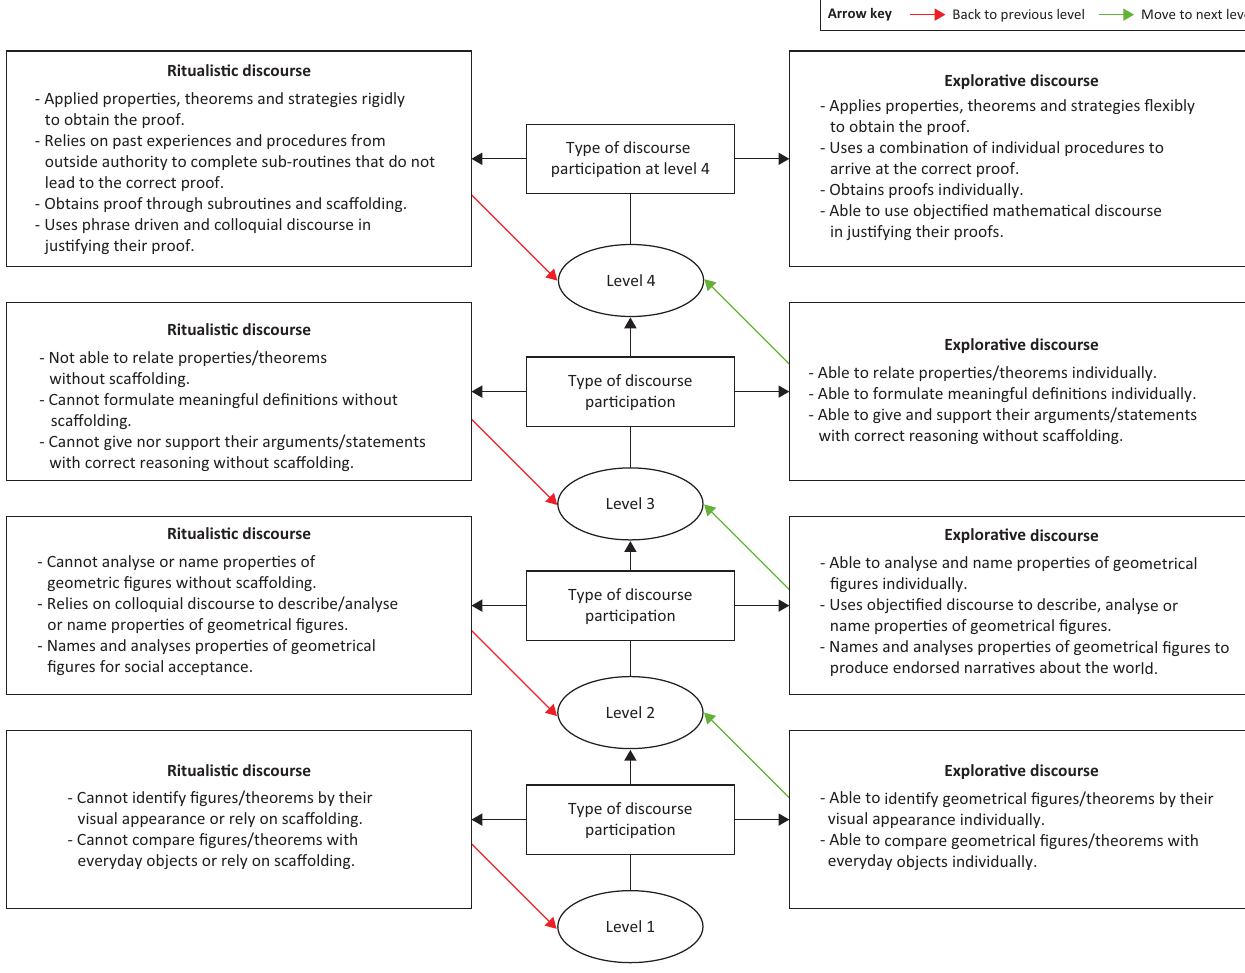
FIGURE 1: A commognitive analysis of pre-service teachers’ geometrical thinking development through Van Hiele levels of geometrical